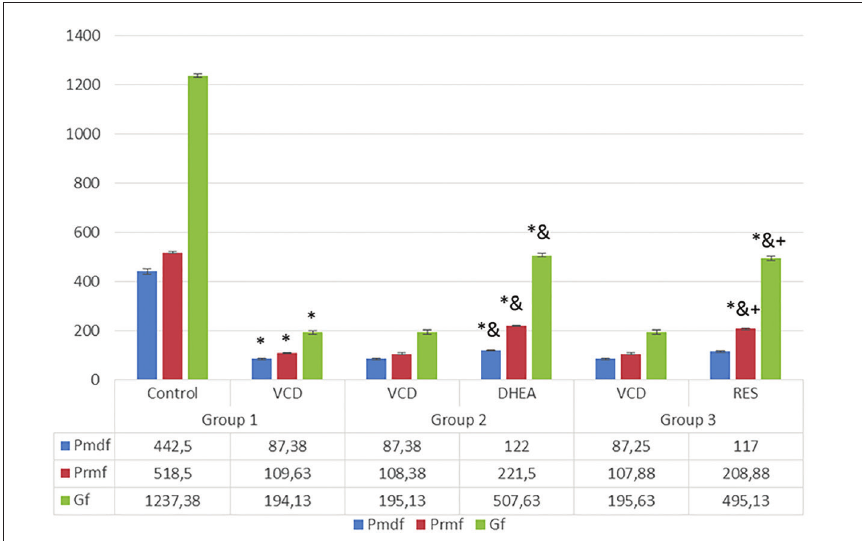
Figure 3. Comparison of primary, primordial, and growing follicle counts. (*): Different from control, (&): Different from VCD, (+): Different from DHEA